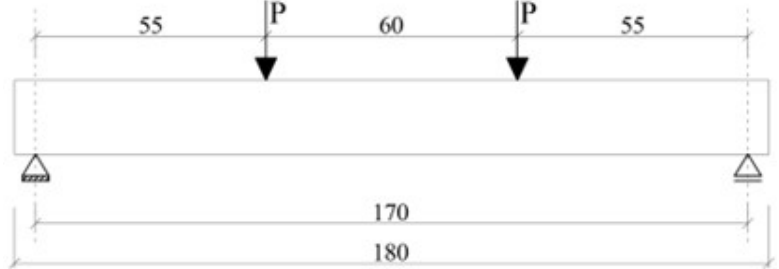
Figure 9. Bending test structural model. Dimensions in